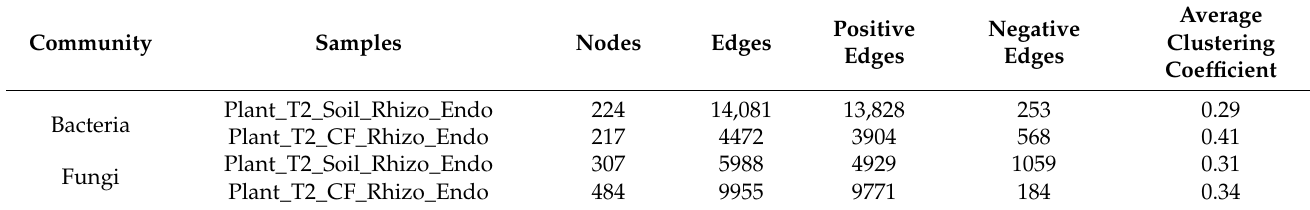
Table 1. Network properties of the bacterial and fungal communities in the root environment (rhizosphere and endorhizosphere) of tomato plants grown in agricultural soil and coconut fiber substrate